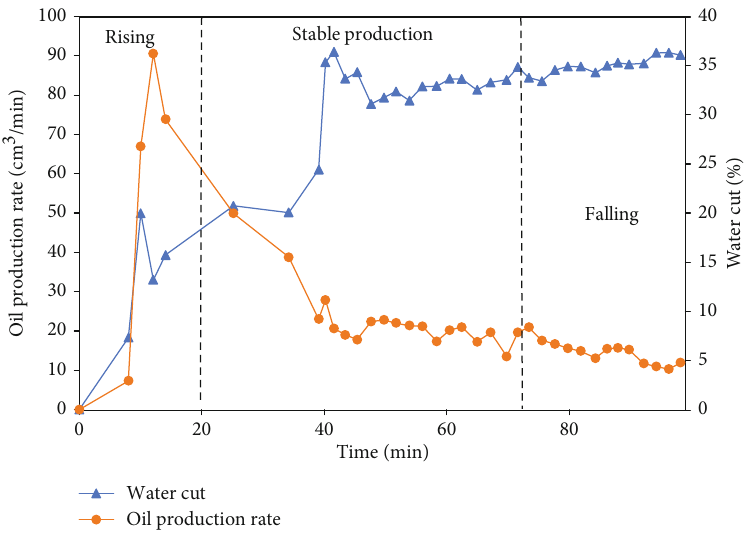
Figure 12: The oil production rate and water cut of 260 ° C superheated SAGD.